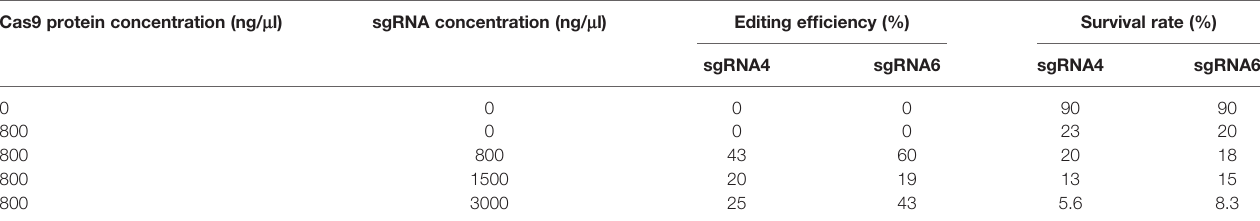
TABLE 4 | The editing ef fi ciency and survival rate of trochophore larvae after injection. Cas9 protein concentration (ng/ m